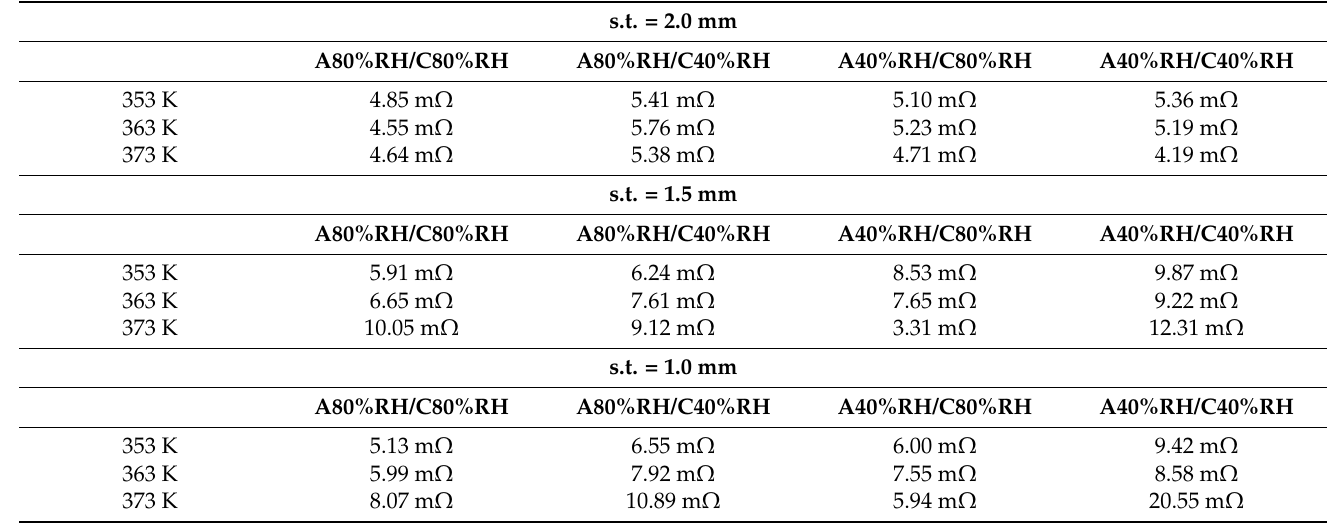
Table 6. Comparison of the reaction and diffusion resistance among various s.t. changing T ini and RH of supply